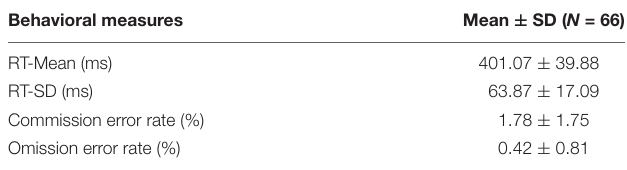
TABLE 1 | Conventional behavioral measures for the task